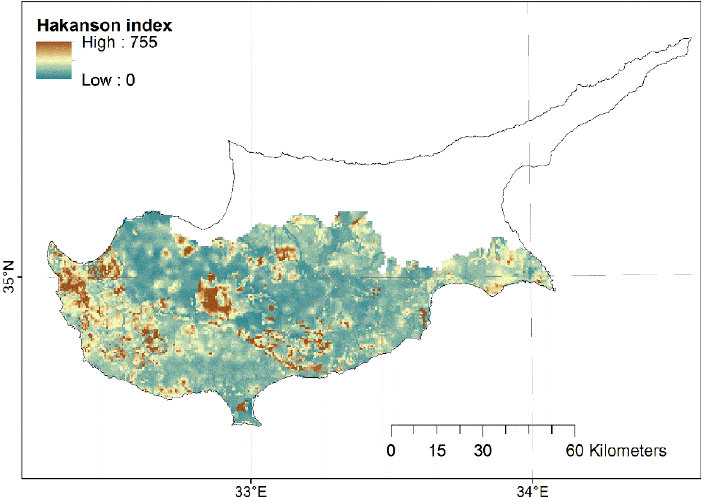
Figure 3. The total Hackanson index raster map created with stratified interpolation (cell size: 500 m; value ranging: histogram equalization; mean value: